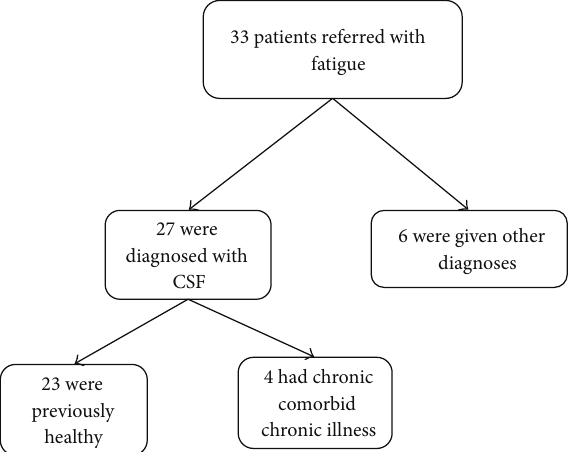
Figure 1: Number of children referred for CFS/ME over a period of